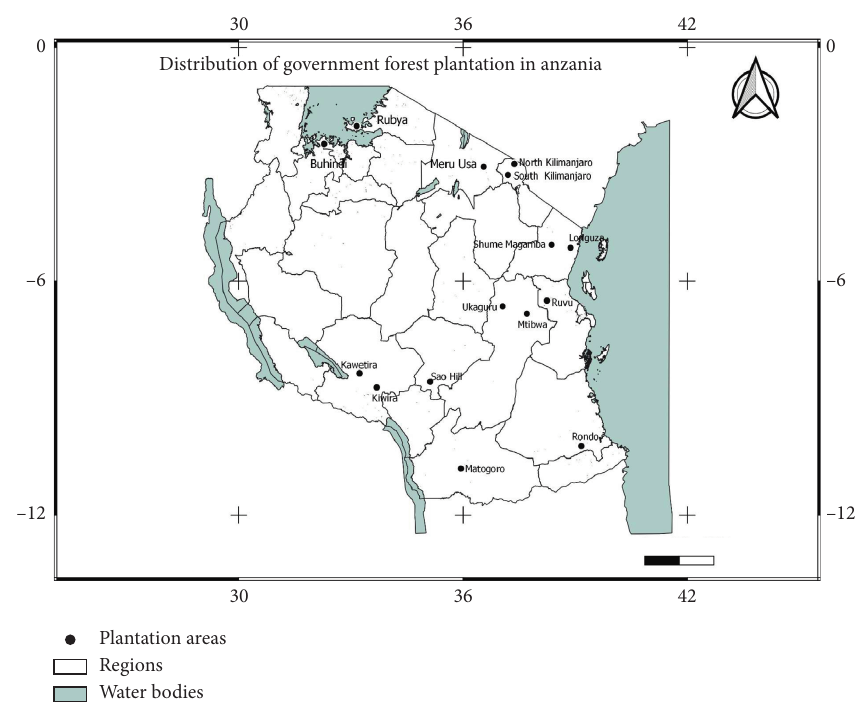
Figure 1: Distribution of government forests in Tanzania (source: